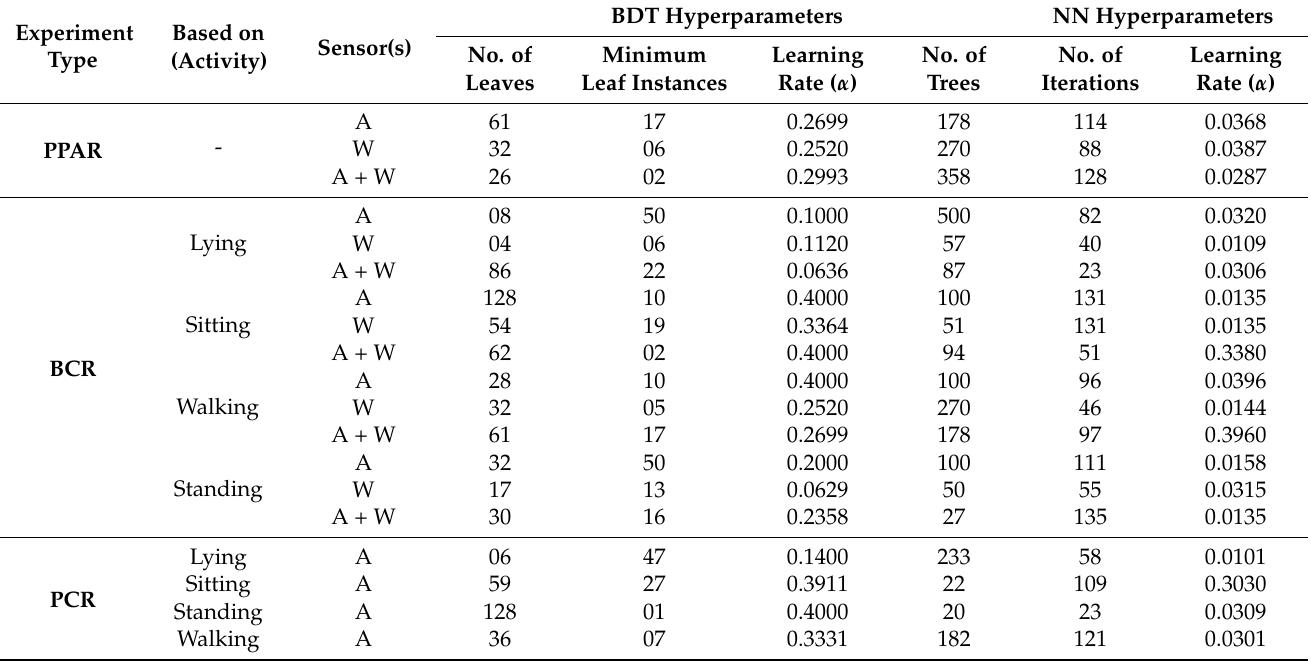
Table 3. Classifier hyperparameters for the best-case recognition results using the proposed